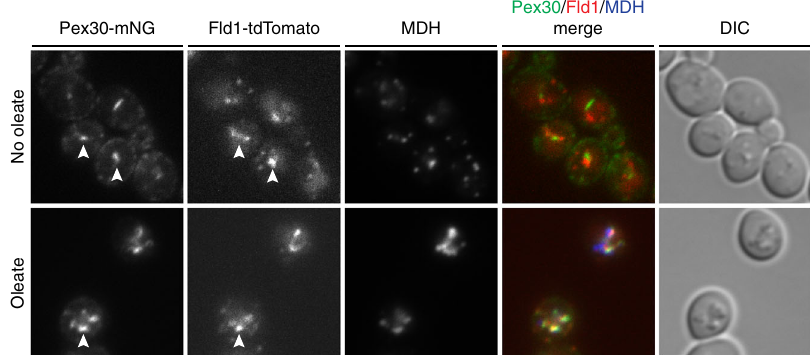
Fig. 3 Relative distribution of Fld1, Pex30, and LDs. Pex30 and Fld1 were endogenously tagged with monomeric Neon Green (Pex30-mNG) and tdTomato (Fld1-tdTomato), respectively. WT cells were imaged in YPD (no oleate) or in oleate-containing medium. LDs were stained with the neutral lipid dye MDH. White arrowheads show regions where Pex30 is located proximal to Fld1. Bar 2